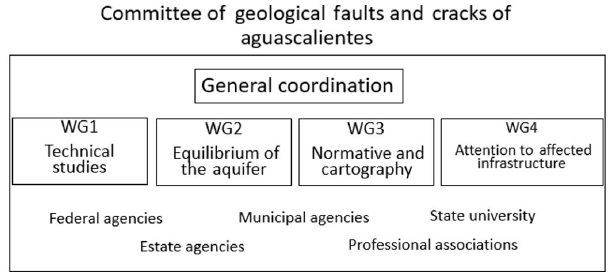
Figure 3. Structure of the